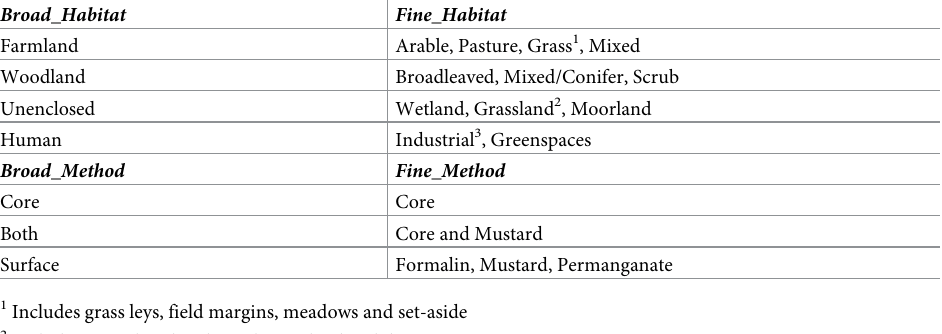
Table 2. Factor levels in the Habitat and Method variables. Base factor is noted first for each variable. Broad_Habitat Farmland Woodland